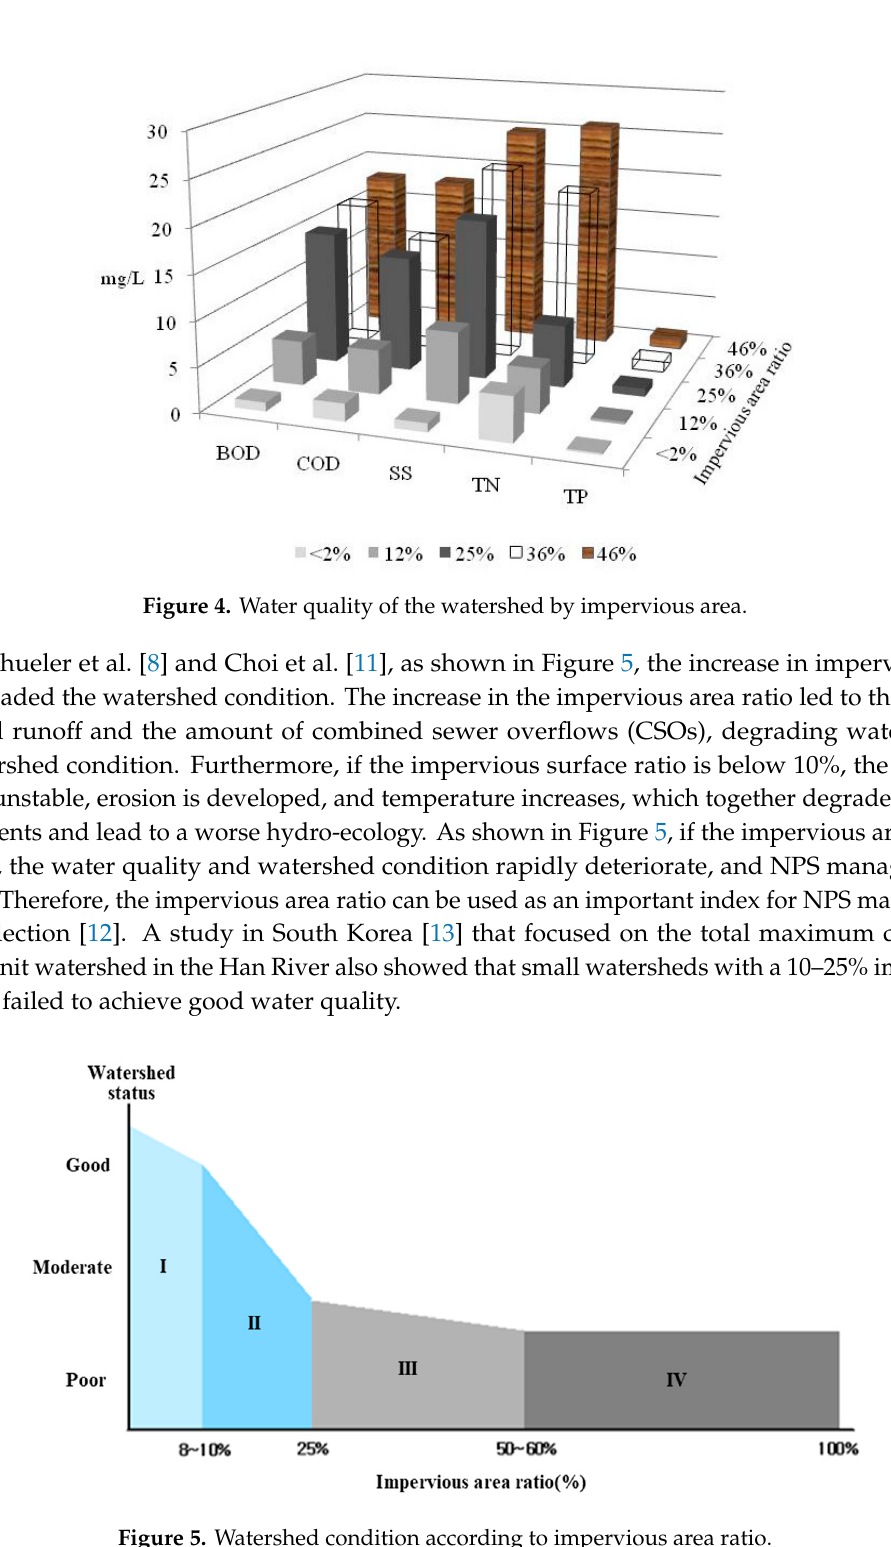
Figure 5. Watershed condition according to impervious area ratio.